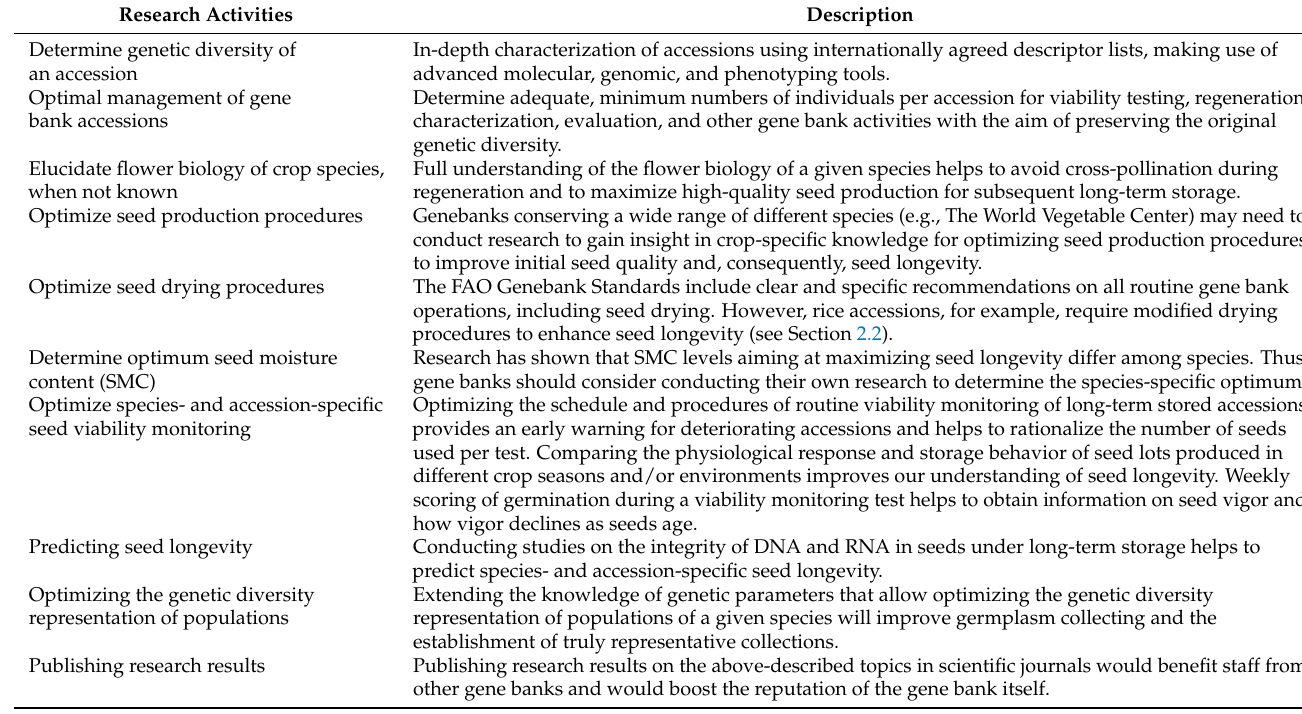
Table 1. Examples of how (routine) research activities can underpin optimum management of germplasm accessions and